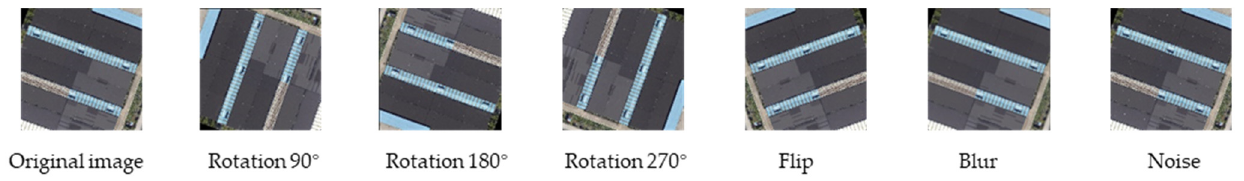
Figure 6. Farmland including raw and labeled images.